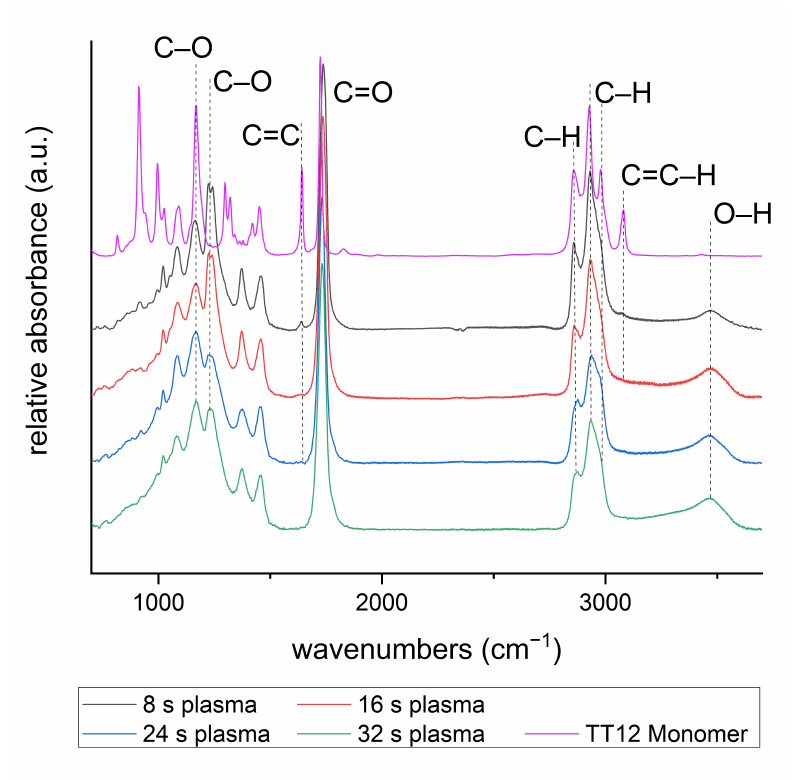
Figure 9. FT-IR spectra of TT12 monomer and as-deposited pp films obtained at different plasma polymerization times.